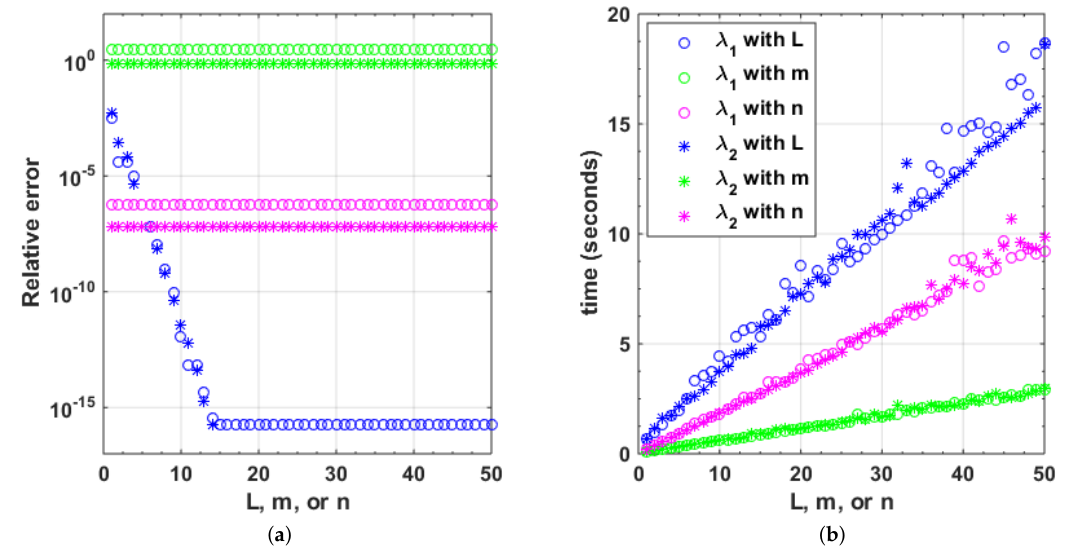
Figure 2. ( a ) Relative error; and ( b ) computation time (in seconds) for the first two eigenvalues λ 1 ( ◦ ) and λ 2 ( ∗ ) of the problem − y (cid:48)(cid:48) = λ y ,0 < x < 1, y ( 0 ) = y ( 1 ) = 0 using Magnus method: for m = 10, L = 5, and n = 1, . . . ,50 (magenta); for n = 10, m = 10, and L = 1, . . . ,50 (blue); for n = 10, L = 1, and m = 1, . . . ,50 (green).